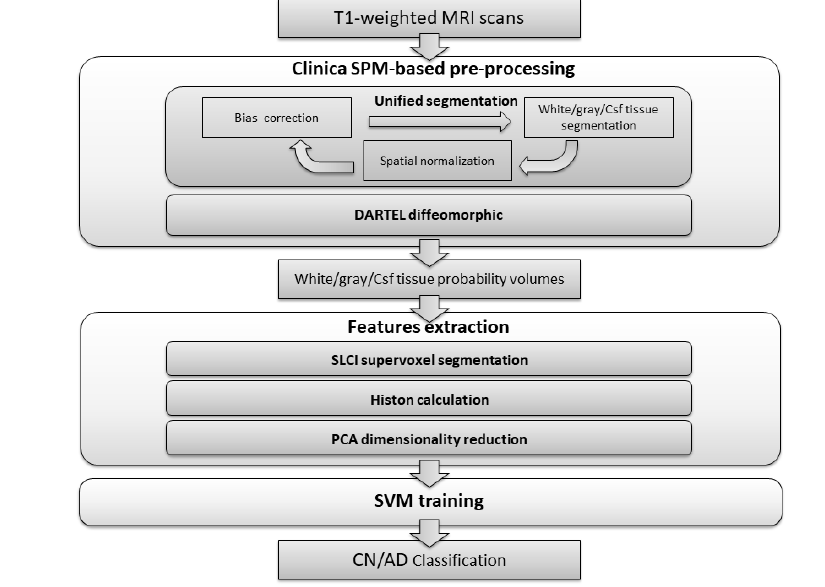
Figure 1. Flowchart of the proposed method.